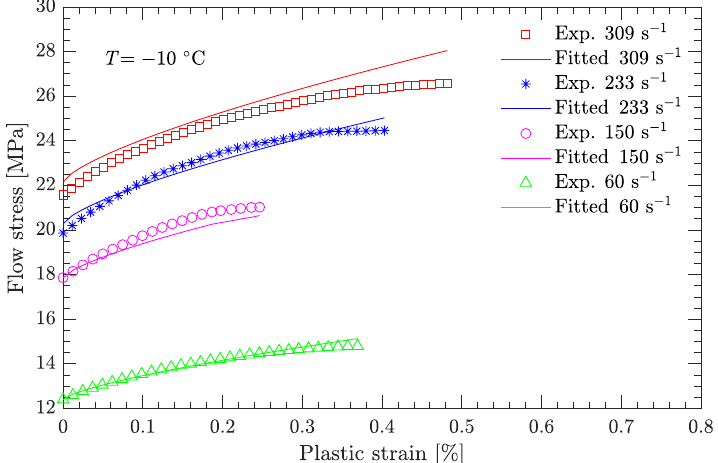
Figure 14. Comparison of fitted and measured flow stresses at a temperature of − 10 ◦